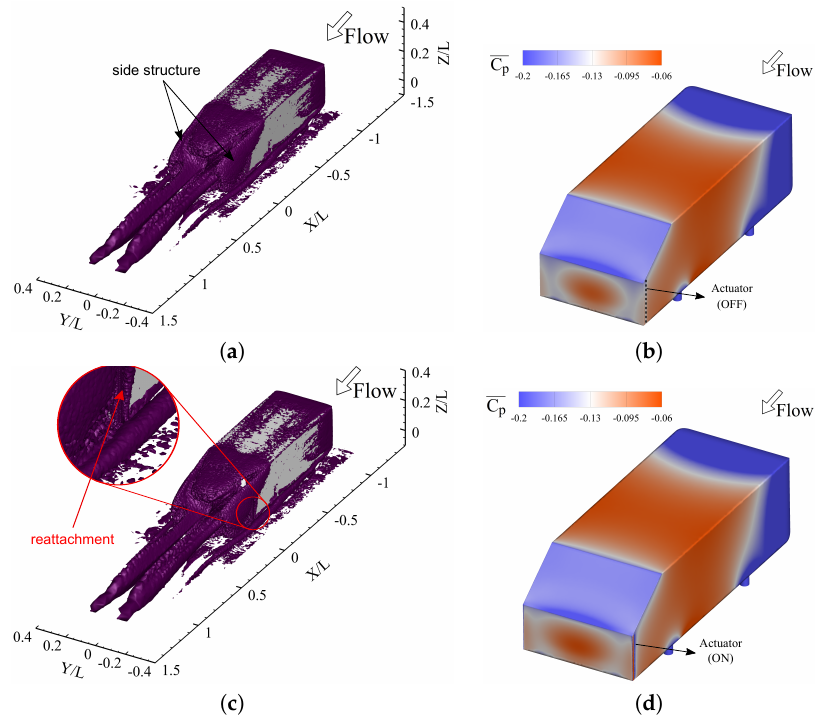
= − 0.004 and contours of surface pressure for case 5 with the slant Figure 16. Isosurface plot of λ ∗ 2 angle of slant angle of 35 ◦ . For ( a , b ), the SDBD actuator is off, and for ( c , d ) the SDBD actuator is on.